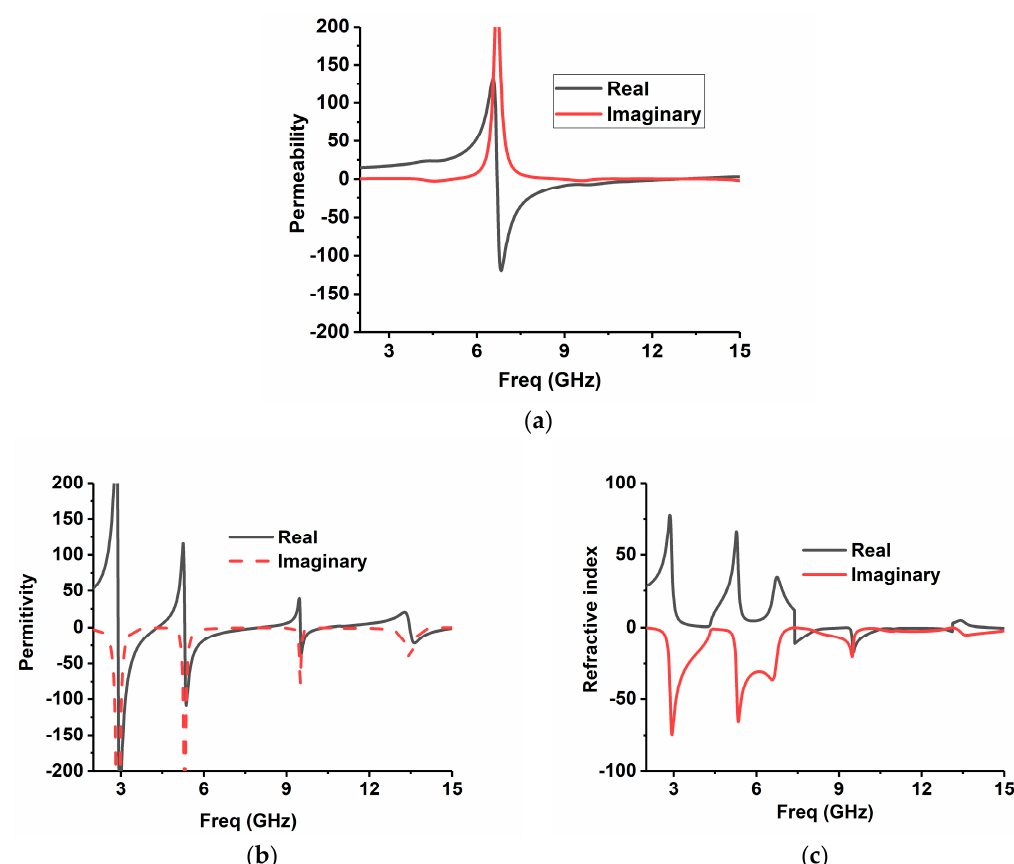
Figure 3. The proposed unit cell ( a ) permeability, ( b ) permittivity, and ( c ) refractive index. Table 2. The permeability, permittivity, and refractive index in the negative frequency zone.